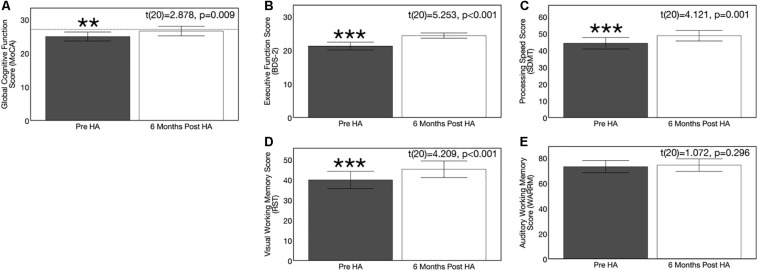
Effects of treatment with hearing aids on cognitive function in age-related hearing loss across 6 months of hearing aid use. Average scores on cognitive measures in the age-related hearing loss group (n = 21) are depicted pre-treatment (gray) and 6 months post-treatment with hearing aids (white). Black bars indicate 95% confidence intervals for each group. Asterisks indicate level of significance (***p ≤ 0.001, **p ≤ 0.01, *p ≤ 0.01). (A) Shows average global cognitive function on a global cognitive screening measure (MoCA) pre- and post-treatment. Higher scores in indicate higher global cognitive function, out of a total score of 30 points. The dotted reference line on the y-axis indicates the cutoff score (≤ 27) indicating risk for mild cognitive impairment. A significant improvement in MoCA score was observed post-treatment in the hearing loss group. (B) Depicts average executive function score (BDS-2) pre- and post-treatment. Higher scores in indicate better executive functioning, out of a total score of 27 points. A significant improvement in executive function score was observed post-treatment in the hearing loss group. (C) Depicts average processing speed score (SDMT) pre- and post-treatment. Higher scores in indicate faster processing speeds in a timed, 90 s digit-symbol matching task A significant improvement in processing speed was observed post-treatment in the hearing loss group. (D) Shows average visual working memory score (RST) in percent words correctly recalled pre- and post-treatment. Higher scores indicate higher visual working memory performance in a dual-task paradigm. A significant improvement in visual working memory recall was observed post-treatment in the hearing loss group. (E) Depicts average auditory working memory score (WARRM) in percent words correctly recalled pre- and post-treatment. Higher scores indicate higher auditory working memory performance in a dual-task paradigm. No significant improvement in auditory working memory recall was observed post-treatment in the hearing loss group. Note: Cognitive testing in the hearing loss group was administered in the same condition across pre-treatment (acutely aided) and post-treatment (aided) test sessions to ensure similar pre-posttest conditions and to reducing potential confounding effects of audibility on cognitive performance at the pre-treatment visit.